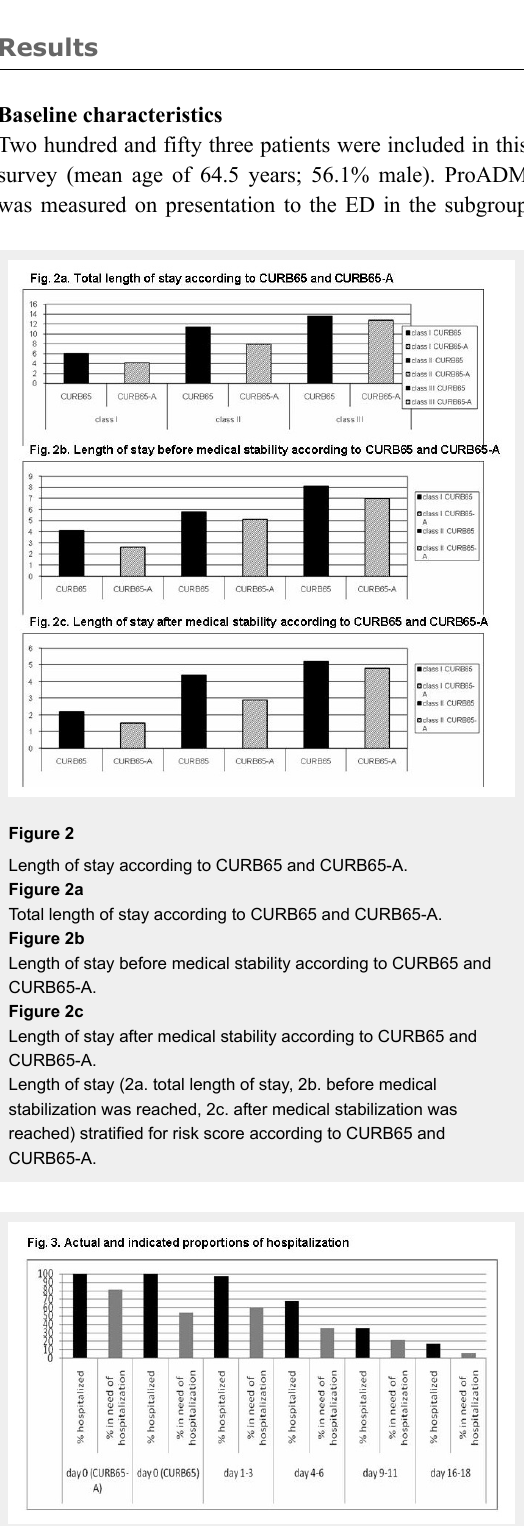
Actual and indicated proportions of hospitalisation. Proportions of patients hospitalised in reality and proportions of patients in need of hospitalisation based on CURB65-A and CURB65 (on admission = day 0) and based on medical stability criteria during hospitalisation. Proportions are depicted as percentage of patients who were initially hospitalised (p for trend <0.001 for CURB65-A; p = 0.83 for